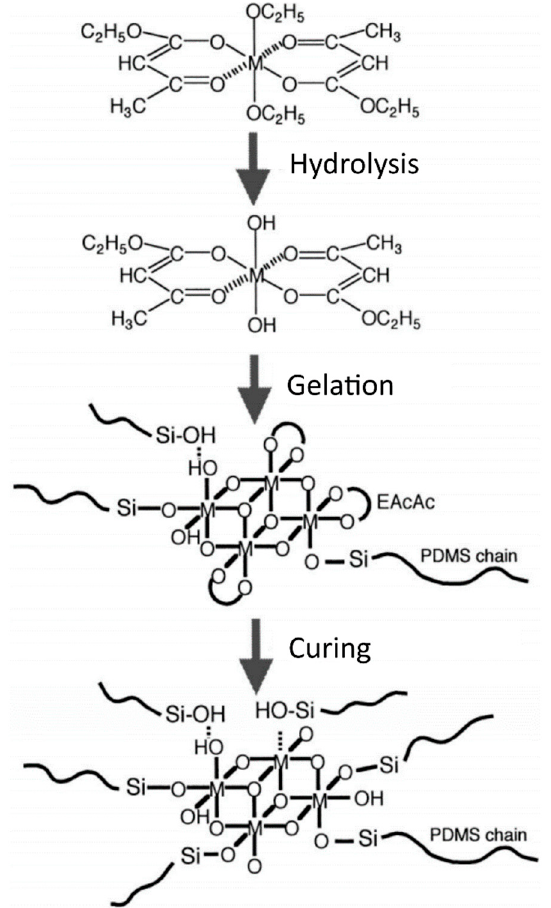
Figure 11. Schematic illustration of the formation of PDMS-based hybrids with metal alkoxide precursors complexed with chelating agent ethyl acetoacetate (EAcAc). Reproduced with permission from Yamada et al. Journal of Sol–Gel Science and Technology ; published by Kluwer Academic Publishers, 2000.